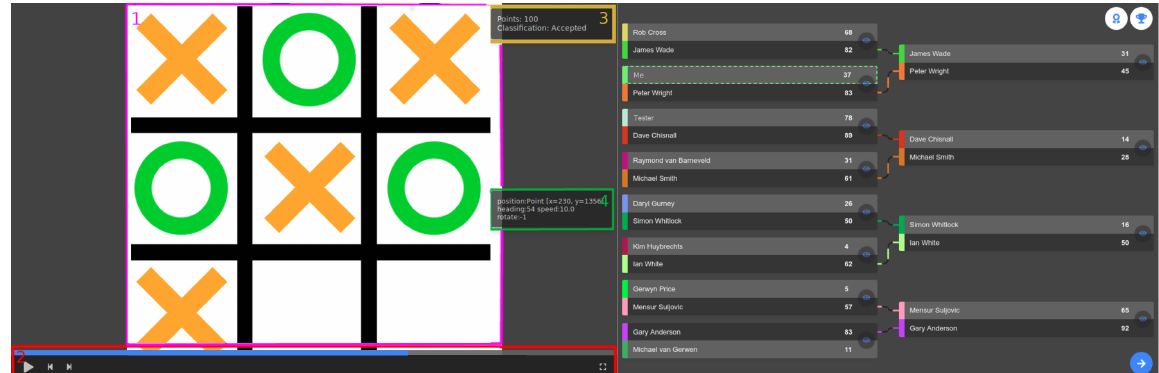
Figure 2. Asura viewer modes. On the left, the match mode with Tic Tac Toe game (distinct areas highlighted in different colors). On the right, the brackets view of the tournament